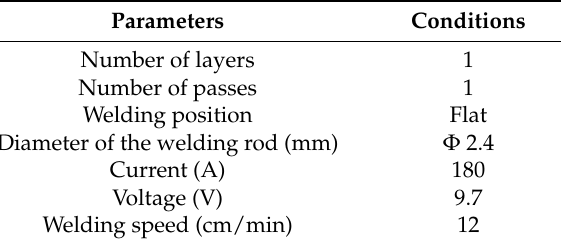
Table 3. Welding conditions.